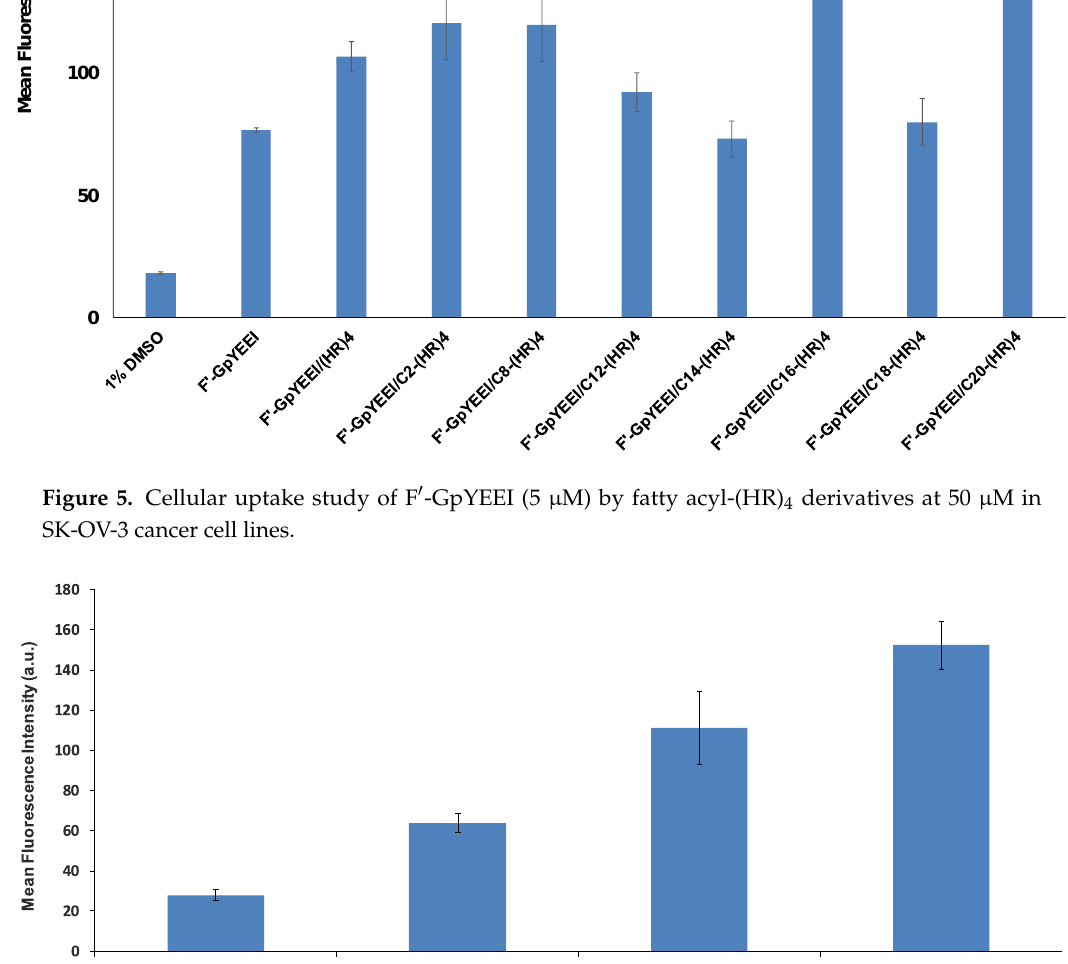
Figure 6. Cellular uptake studies F’-GpYEEI (5 µM) in the presence of C 20 -(HR) 4 in SK-OV-3 cell lines at a concentration of 5, 10 and 50 µM of C 20 -(HR) 4 .